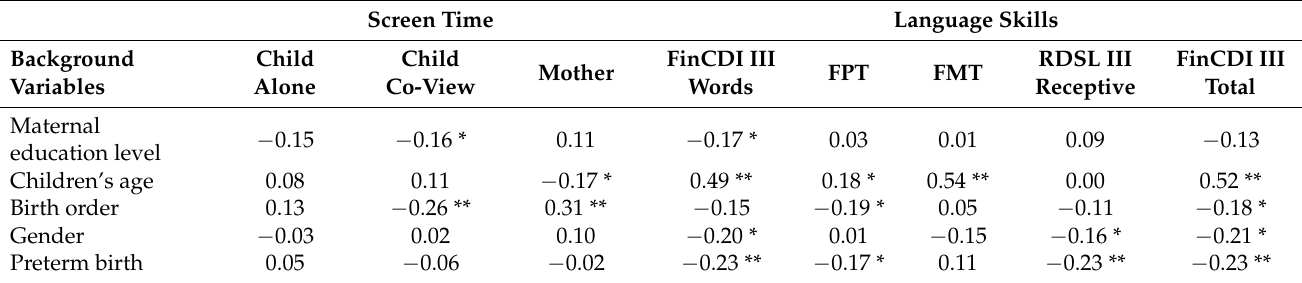
Table A1. Pearson’s correlation co-efficient values (r) between background variables and screen time of children and mothers, and children’s language